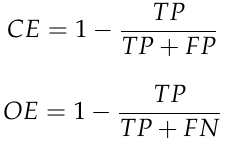
Figure 6. Structure of the attention block.